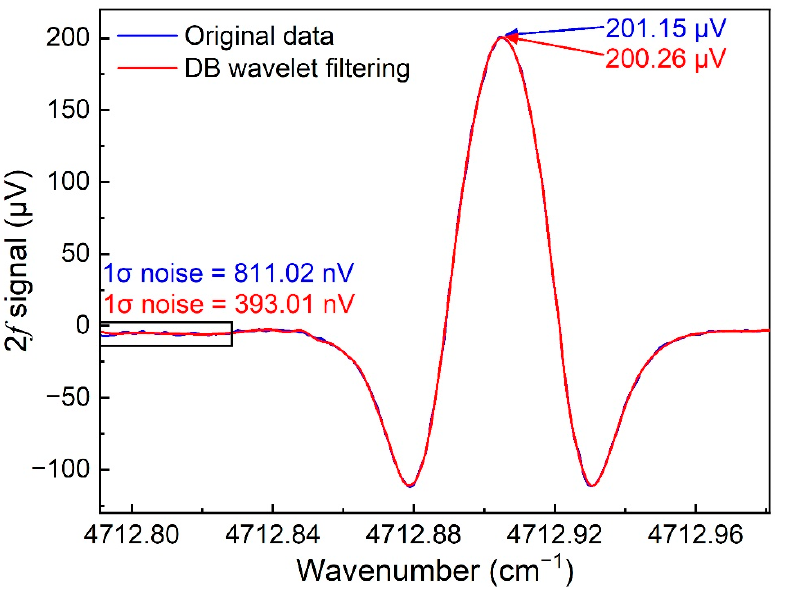
Figure 8. H 2 -TDLAS 2 f signal comparison without and with the DB wavelet denoising when H 2 concentration is 100%.